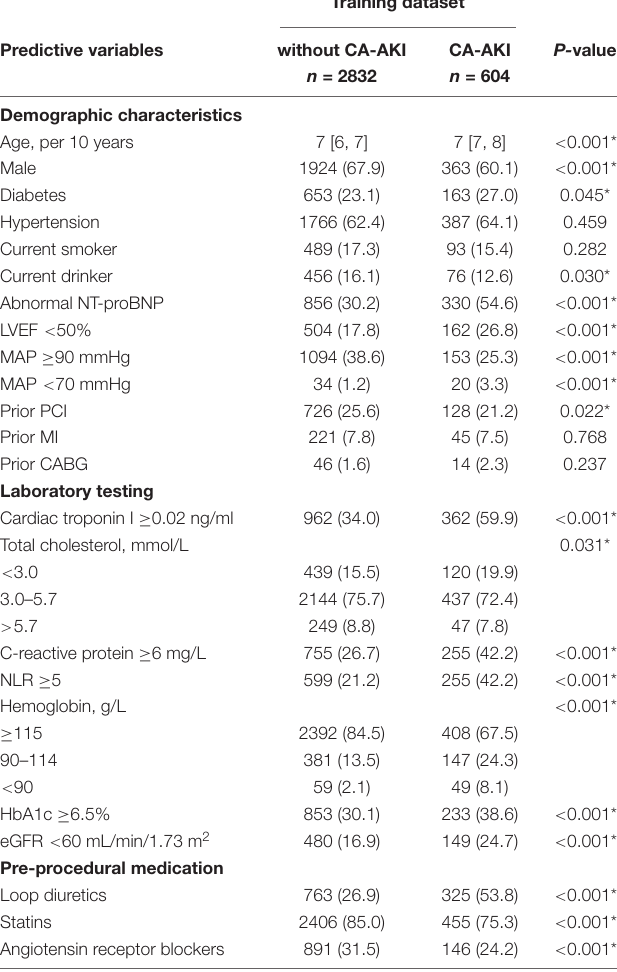
TABLE 1 | Summary of predictive variables according to CA-AKI in the testing